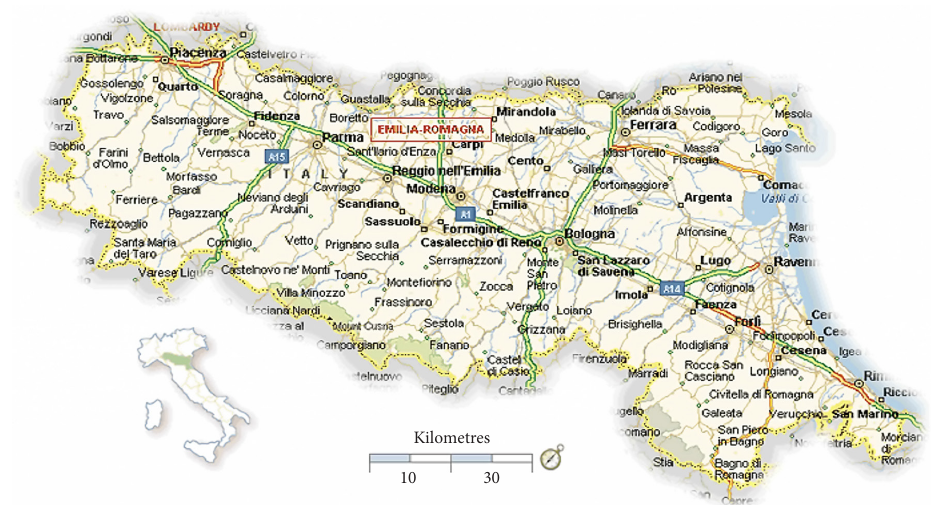
Fig. A1. The Emilia Romagna Region (5 millions inhabitants, GDP per capita 33,000€,